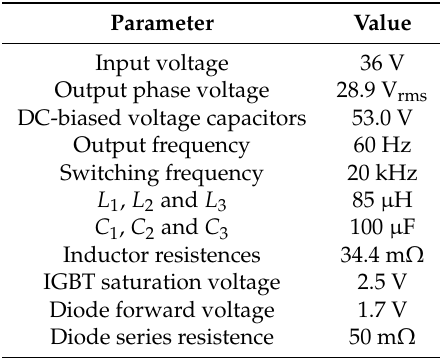
Table 1. Main parameters of the